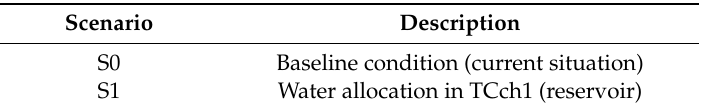
Table 8. Description of the two chosen scenarios.